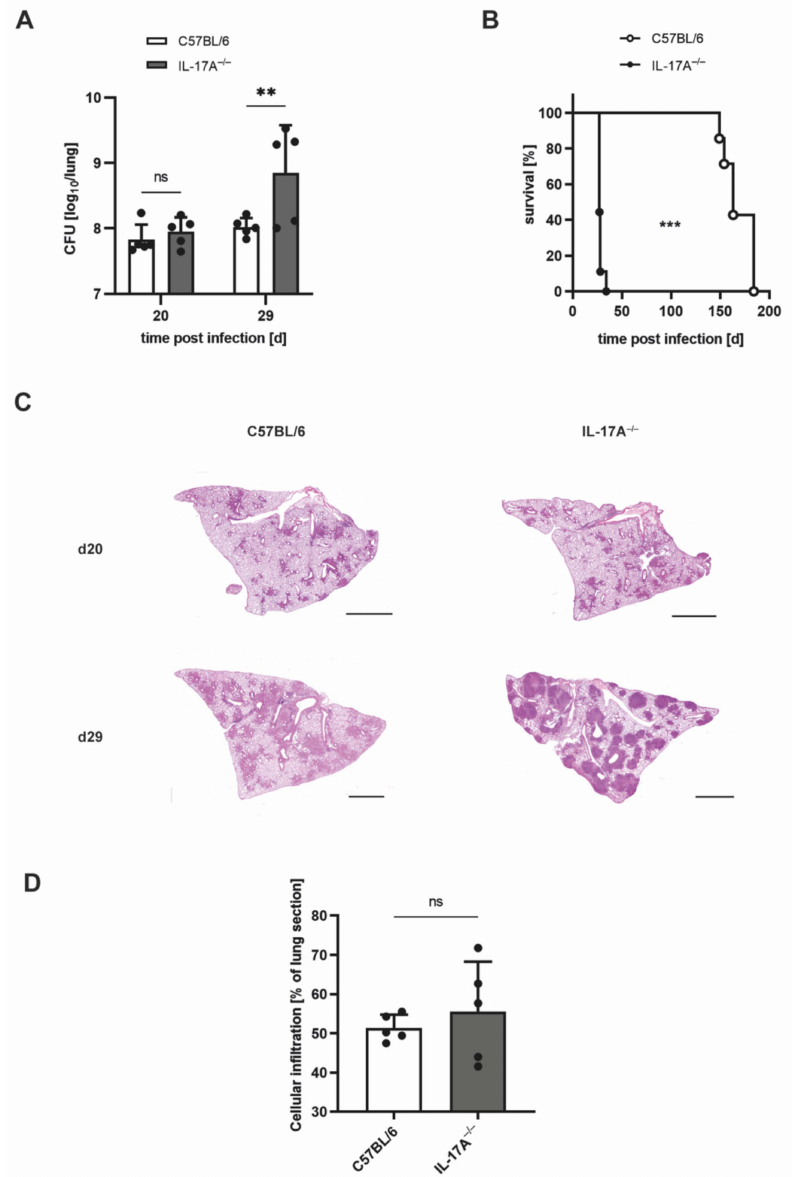
Figure 4. After ultrahigh-dose infection with Mtb, considerably shortened survival in IL-17A − / − mice is partially accompanied by pronounced granulomatous lesions in the lung. ( A – D ) C57BL/6 and IL-17A − / − mice were infected with >1000 CFU of H37rv Mtb by an aerosol. ( A ) At different time points of infection, CFUs in the lungs were determined. Data are presented as single dots and as the mean ± SD of 5 mice per group from one representative experiment. Statistics were determined for log-transformed data using a two-way ANOVA with Bonferroni’s post hoc test. Differences between C57BL/6 and IL-17A − / − mice were defined as significant (ns p ≥ 0.05; ** p < 0.01). ( B ) The